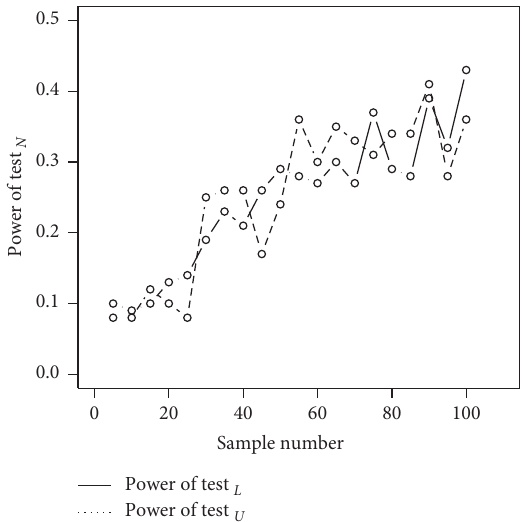
Figure 2: Power curve for the neutrosophic chi-square distribution.